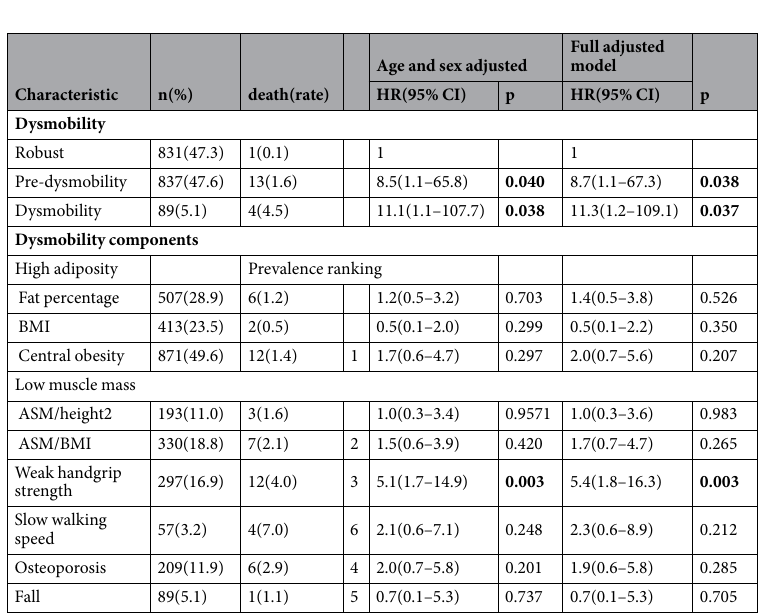
Table 2. Prevalence and risk of mortality of dysmobility component conditions in the I-Lan Longitudinal Aging Study ASM, appendicular skeletal muscle; BMI, body mass index; bold type indicated statistical significance; Full model was adjusted by age, sex, the autonomy assessment scale, Charlson comorbidity index, smoke and alcohol